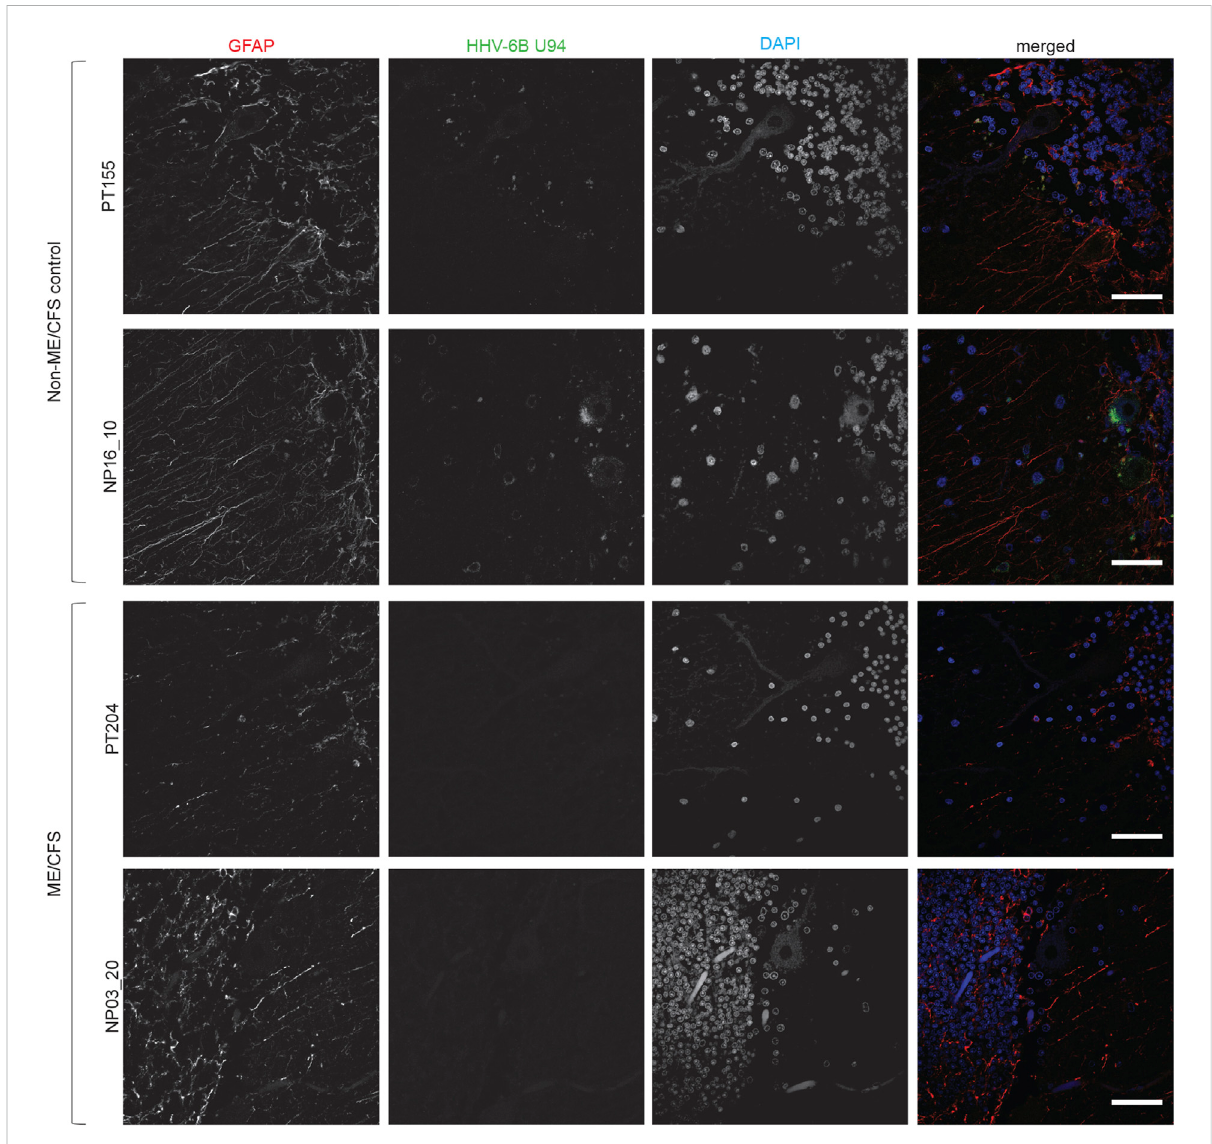
FIGURE 3 Absence of HHV-6 infection in cerebellum of ME/CFS patients. Representative images showing Immuno fl uorescence analysis for HHV-6B U94incerebellumsamples.CerebellumsampleswerestainedusingantibodyagainstHHV-6BU94togetherwithGFAP(markerforastrocytes).DAPI was used to counterstain DNA. Each panel represents a different ME/CFS patient or a non-ME/CFS control. The scale bars represent 100 μ